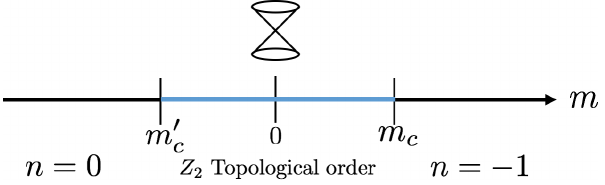
FIG. 10. If the SU ð 2 Þ þ N A ¼ 1 theory is dual to a single Dirac f fermion supplemented by a Z 2 topological order, the adjoint fermion mass will not drive the system to the large-mass confined phase immediately as the Z 2 topological order is stable against small perturbations. Increasing the fermion mass, the Z 2 topo- logical order should go through another phase transition to the confined